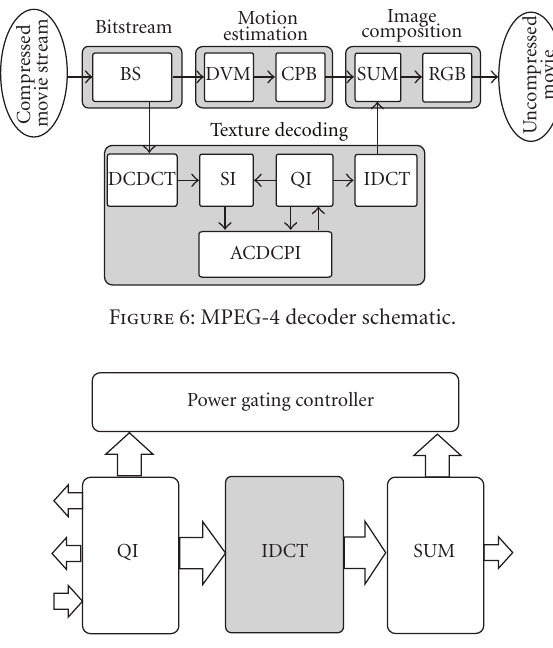
Figure 7: IDCT and PGC submodule connections.